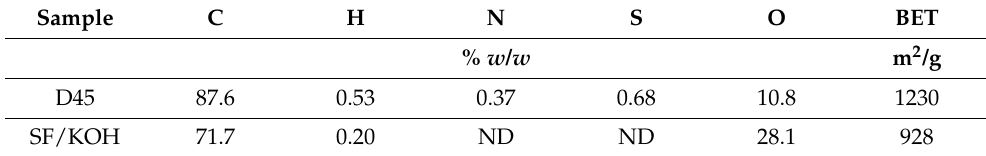
Figure 1. IR spectra of initial materials, as well as after every corresponding treatment stage, i.e., by HNO 3 , by thiol-functionalization with MeOH, or by water matrix: ( a ) D45; ( b ) SF/KOH. Table 1. Elemental analysis and surface area of the carbonaceous materials.